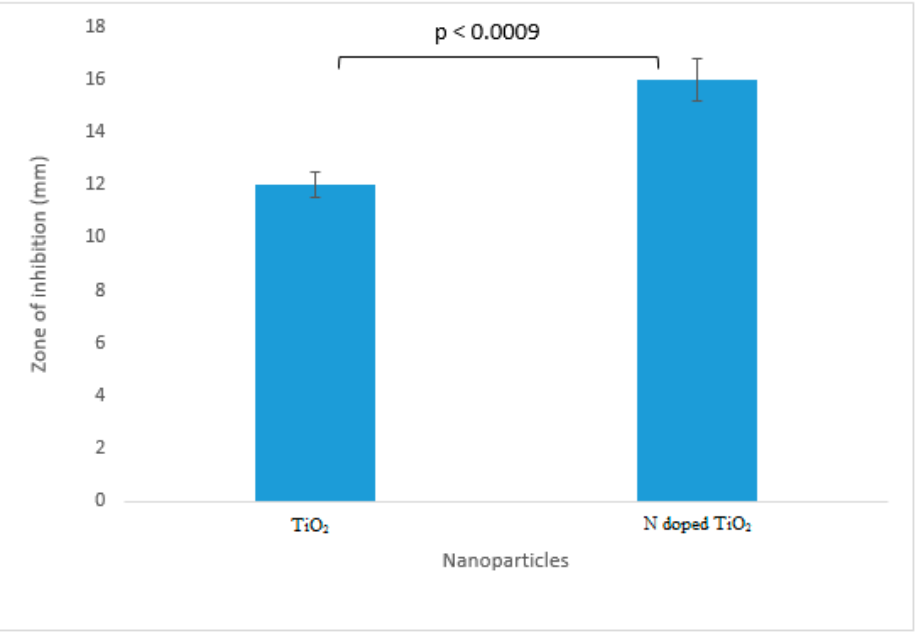
Figure 13. Protein kinase inhibitory activity: Zone of inhibition obtained against bacterial strain, Streptomyces by control, TiO 2 nanoparticles and N-doped TiO 2 nanoparticles. 2.9. Cytotoxic Activity Brine shrimp lethality assay was an appropriate preliminary test for screening of cytotoxicity of undoped TiO 2 nanoparticles and N-doped TiO 2 nanoparticles. Figure 14 shows that lesser